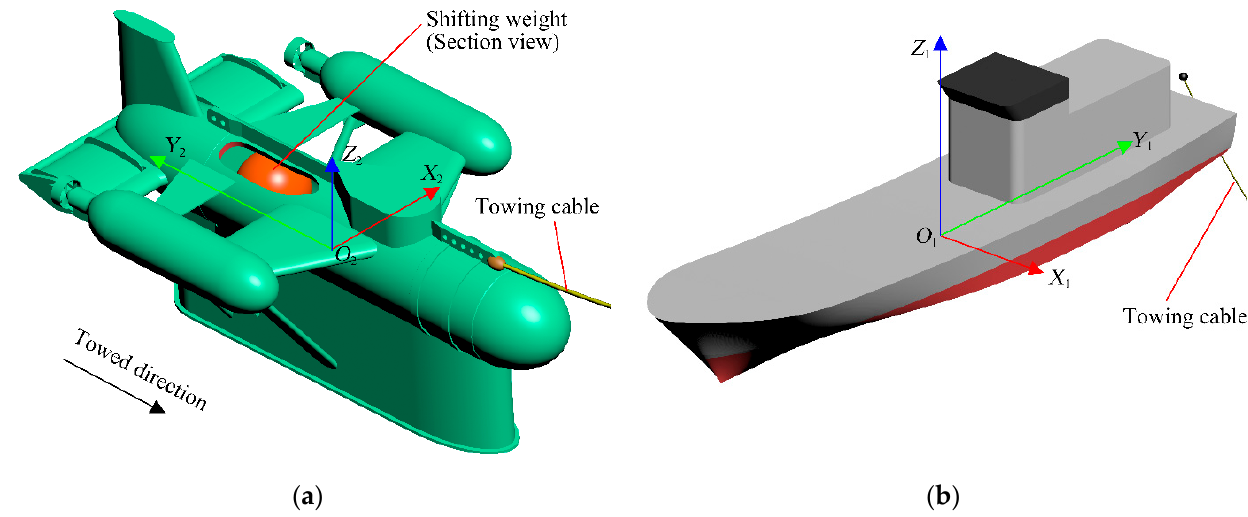
Figure 2. The geometric model: ( a ) the simplified towed vehicle; ( b ) the simplified towing ship.